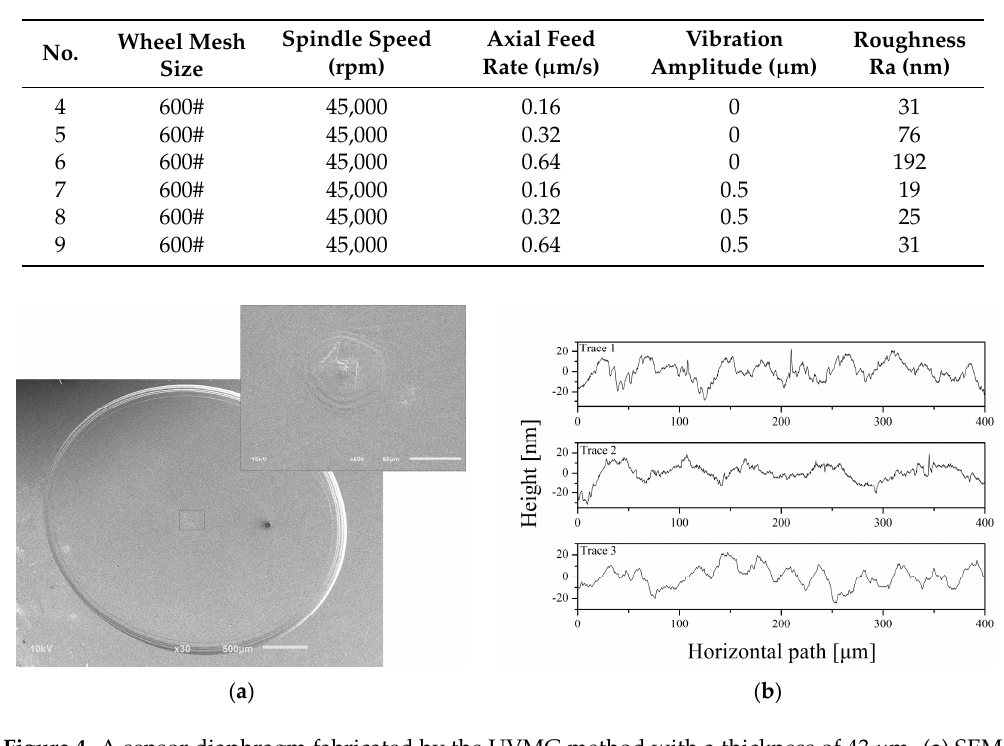
Figure 4. A sensor diaphragm fabricated by the UVMG method with a thickness of 43 µm. ( a ) SEM images, ( b ) measured surface roughness with a trace length of 400 µm.